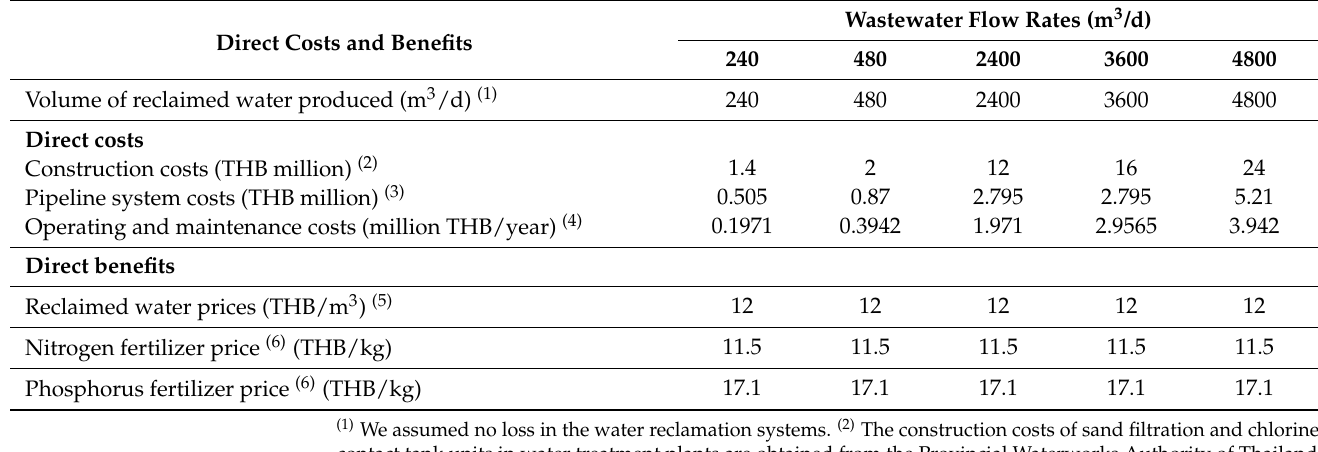
Table 2. Information for estimating the direct costs and benefits of water reclamation projects for the irrigation of plants and green areas, consisting of sand filtration and